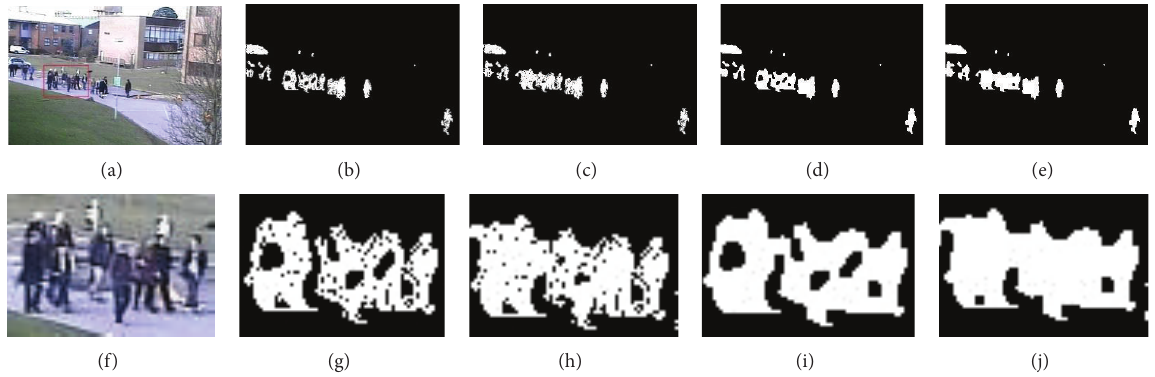
Figure 5: Comparison of “MoG with frame difference” and “MoG with blob tracking and frame difference”: (a) a frame (number 050) from the video with crowded people, (b) result of original MoG with frame difference, (c) result of MoG with blob tracking and frame difference, (d) and (e) results after a close operation of (b) and (c) separately, and (f), (g), (h), (i), and (j) in the bottom are the detail of center part of the above